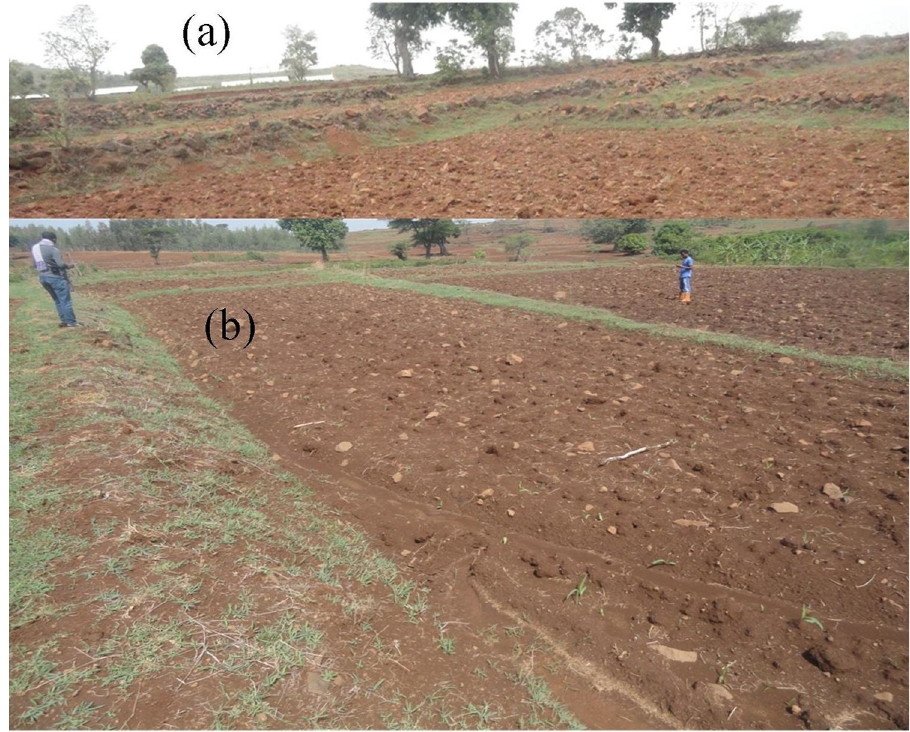
Fig 3. Treated with stone-faced soil bunds (a) and with soil bunds (b) at the upper and lower slopes in Aba Gerima